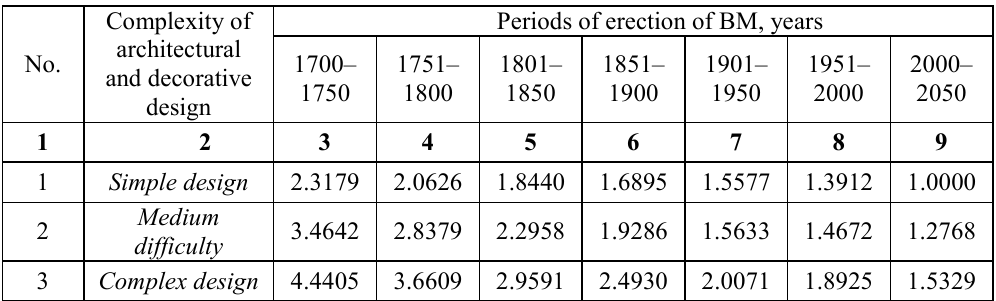
Table 2. Indices of Cost Replacement (in the cost of restoration)